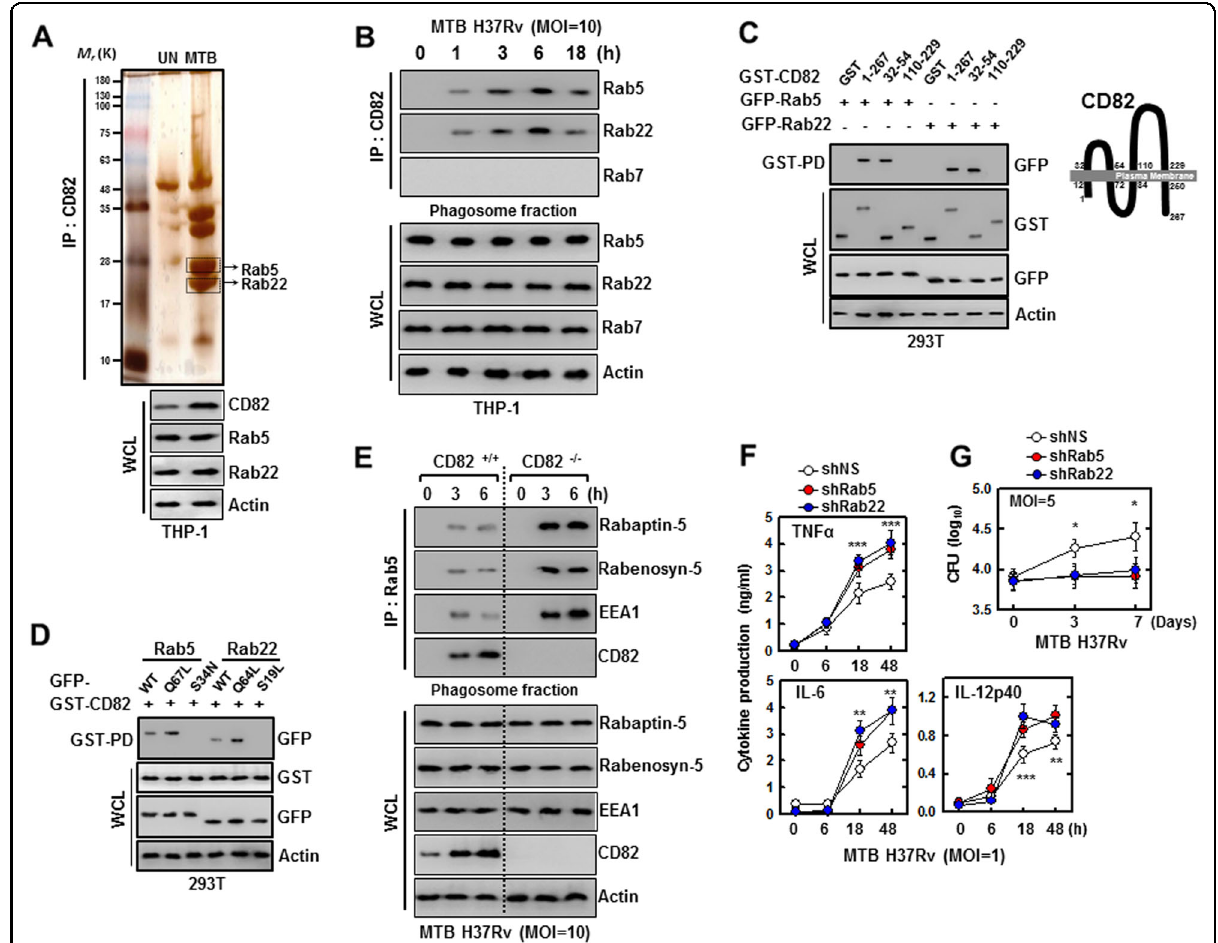
Fig. 3 CD82 interaction with Rab5 and Rab22 leads to bock maturation. a Identi fi cation of Rab5 and Rab22 by mass spectrometry analysis in THP-1 cells were infected with MTB Rv or MTB Ra (MOI = 5) for 3 h. Whole cell lysates (WCLs) were used for IB with α CD82, α Rab5, α Rab22, and α Actin. b , e THP-1 cells ( b ) and BMDMs ( e ) from CD82 + / + and CD82 − / − were infected with MTB Rv for the indicated times. Mycobacteria-containing phagosome fractions were subsequently puri fi ed by sucrose-step-gradient-ultra-centrifugation, followed by immunoprecipitation (IP) with α CD82 ( b ) or α Rab5 ( e ) and IB with α Rab5, α Rab22, α Rab7 ( b ) or α Rabaptin-5, α Rabenosyn-5, α EEA1, α CD82 ( e ), and α Actin. c Binding mapping. (Left) At 48 h post transfection with mammalian GST or GST-82 and truncated mutant constructs together with GFP-Rab5 or GFP-Rab22, 293T cells were used for GST pulldown, followed by IB with α GFP. WCLs were used for IB with α GST, α GFP or α Actin. (Right) Schematic diagrams of the structure of CD82. d 293T cells were co-transfected with GST-CD82 with GFP-Rab5 or GFP-Rab22 and truncated mutant, and subjected to GST pulldown, followed by IB with α GFP. WCLs were used for IB with α GST, α GFP or α Actin. f BMDMs were transduced with lentivirus-shRNA-NS or lentivirus-shRNA-Rab5 or Rab22 for 2 days and infected with MTB Rv for the indicated times. Culture supernatants were harvested and analyzed for cytokine ELISA for TNF α , IL-6, and IL-12p40 ( f ) or intracellular survival of MTB was assessed by CFU assay ( g ). The data are representative of four independent experiments with similar results ( a – e ). Data shown are the means ± SD of six experiments ( f , g ). Signi fi cant differences (* P < 0.05; ** P < 0.01; *** P < 0.001) compared with shRNA-NS (Student ’ s t- test with ANOVA for multiple comparisons). CFU colony-forming